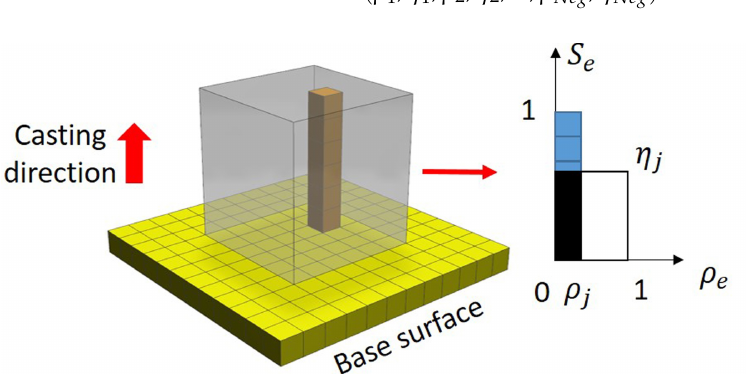
Figure 1. Parametric sketch of element density considering draft